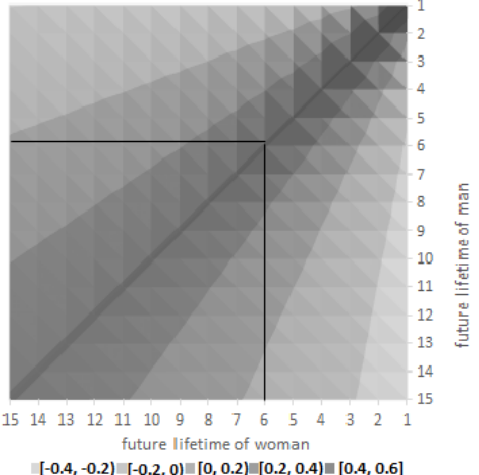
Figure 3. The relative increase in benefits in both variants for spouses aged 75.